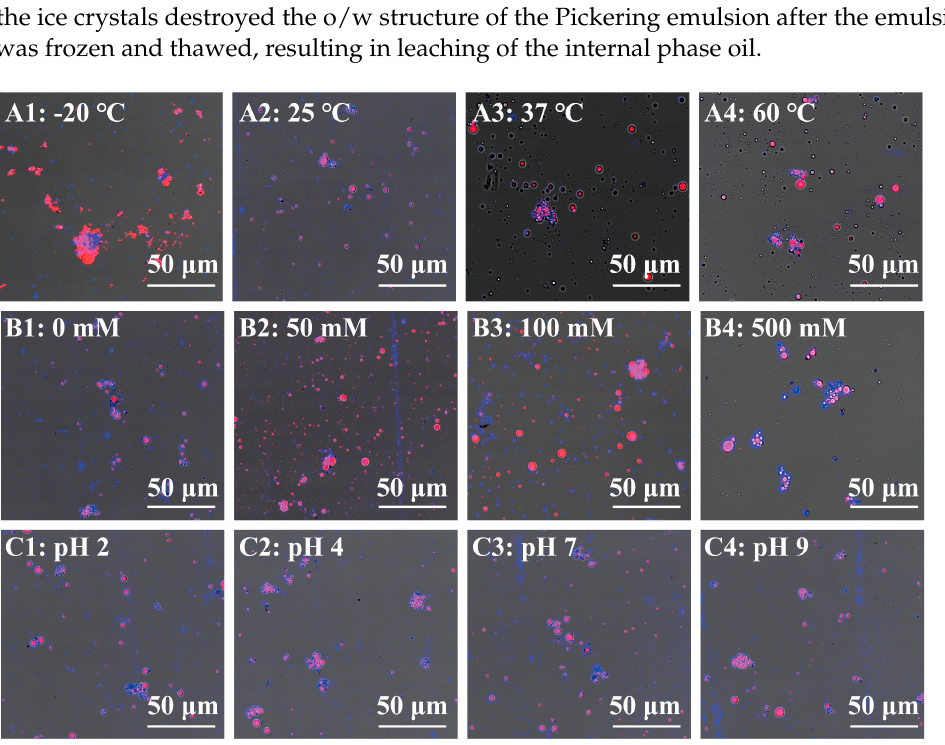
Figure 2. Confocal laser scanning microscopy (CLSM) images of the Pickering emulsion under dif- ferent environmental stresses. ( A1 – A4 ) pH, ( B1 – B4 ) temperature, and ( C1 – C4 ) salt concentration.